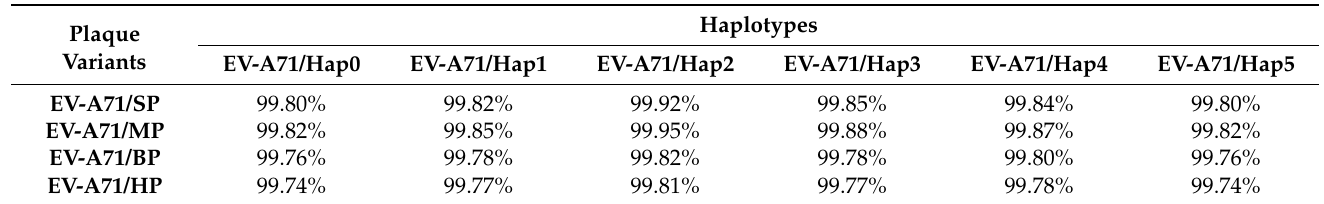
Table 3. Similarity nucleotide sequences of plaque variants EV-A71/SP, EV-A71/MP, EV-A71/BP and EV-A71/HP with all the six haplotypes.